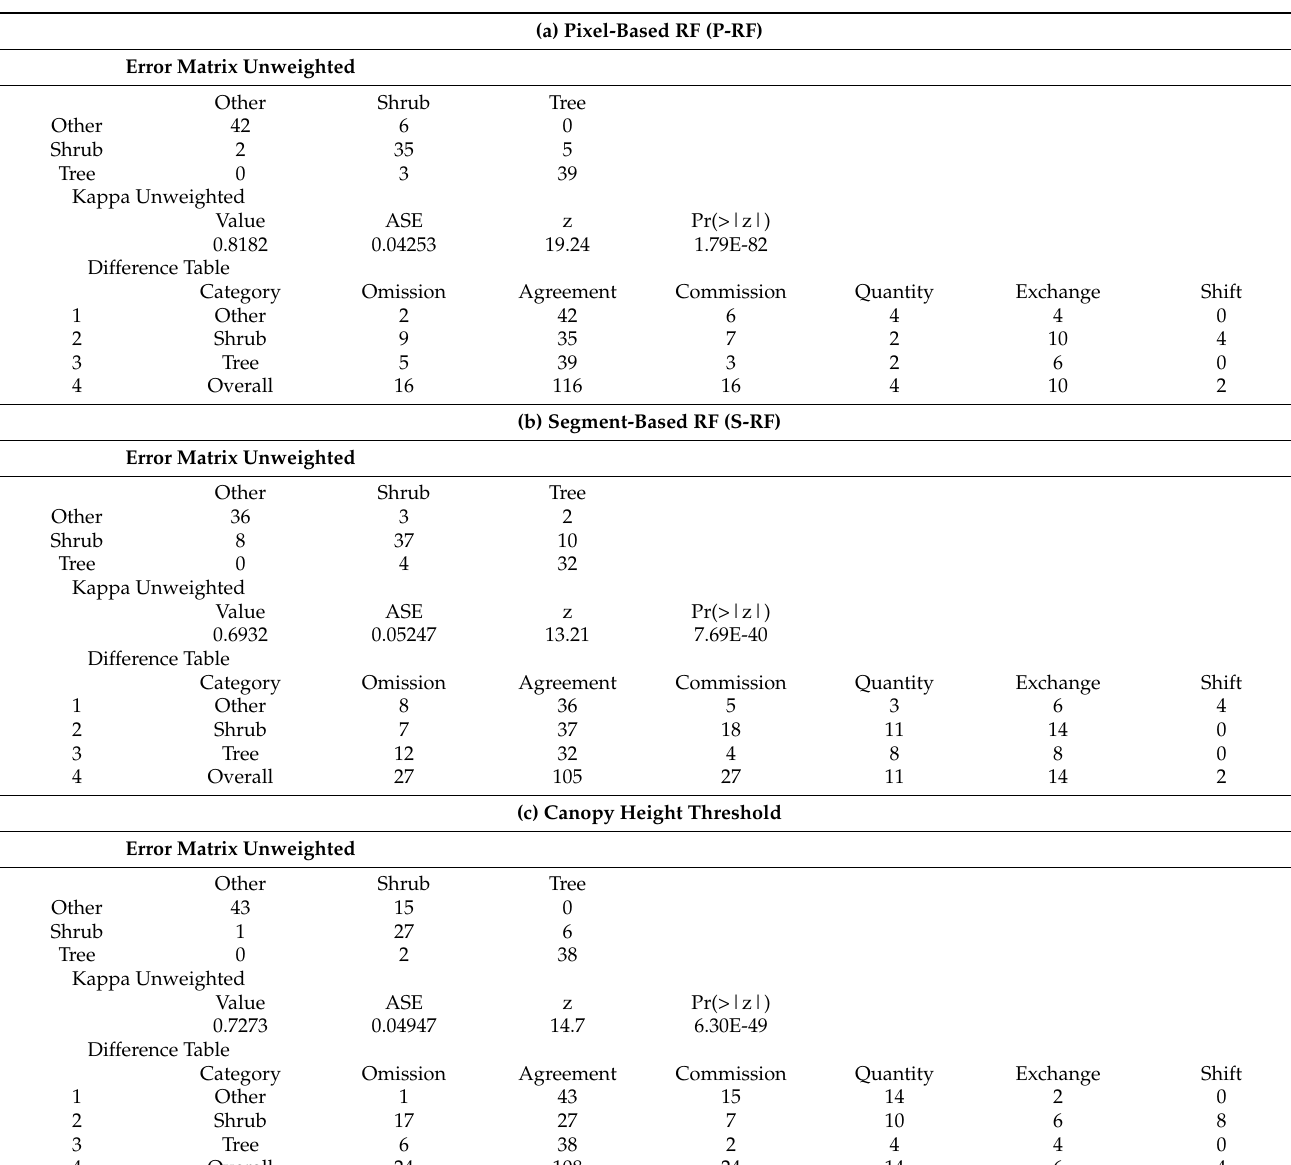
Table 2. Classification assessment output for ( a ) P-RF, ( b ) S-RF, and ( c ) threshold techniques for quantifying fractional vegetation